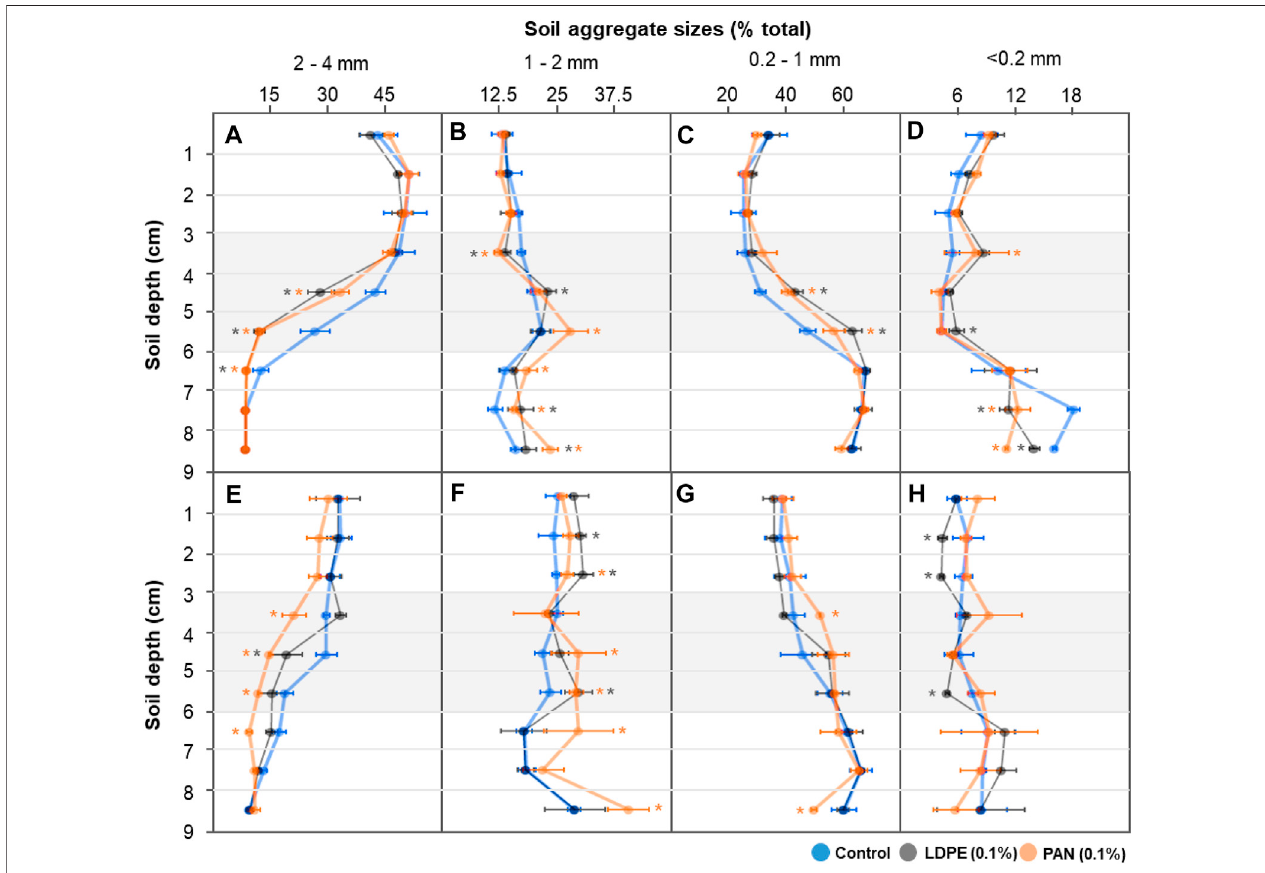
FIGURE 4 | Soil aggregate size fractions (2 – 4; 1 – 2; 0.2 – 1; < 0.2 mm) at each depth (0 – 9 cm) after low-level irrigation. Each soil column was incubated for 1 day (A – D) and 60 days (E – H) . Asterisk represents signi fi cance at the level of 5% ( p (cid:2) 0.05) between control and microplastic-containing soil layer